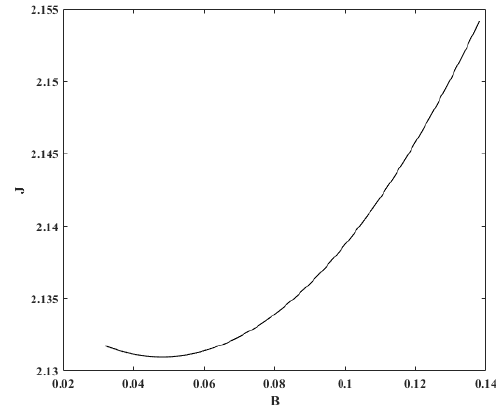
Figure 9. The values of function J under different settings of parameter B.